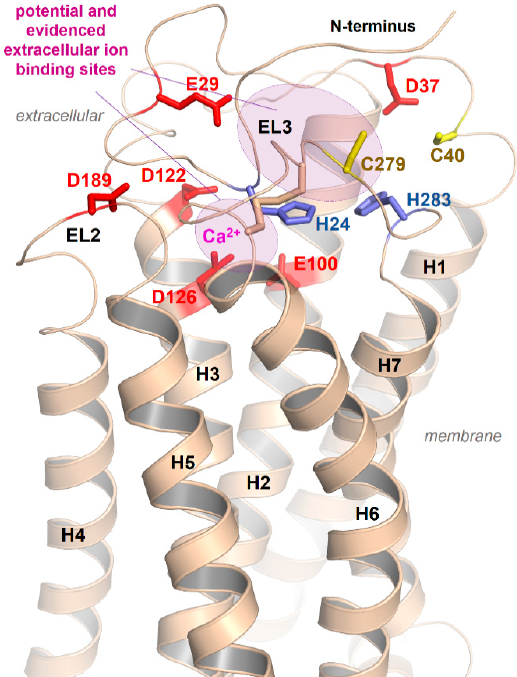
Figure 6. Potential extracellular cation binding sites at the MC4R. In addition to the above-described sodium binding sites between TMH2, -3, and -7 (Figure 5) and the detected calcium binding site close to the extracellular part (Figure 4) [21], several additional extracellular amino acids (negatively charged as Asp and Glu, or His and Cys as zinc binding motifs) should contribute to copper, calcium, or zinc ion binding as indicated in the model.